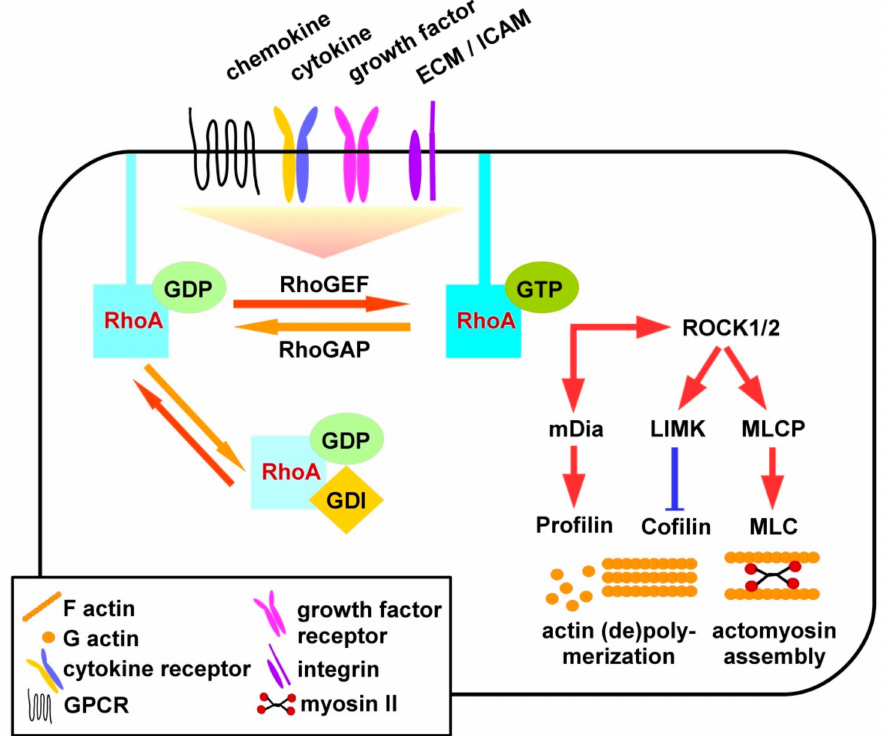
Figure 1. Scheme of RhoA signaling. Binding of exogenous ligands via di ff erent types of receptors as well as intracellular events trigger activation of RhoA GEF which, in turn, engage membrane-bound RhoA and mediate the exchange of GDP by GTP resulting in RhoA activation. GAP elevate the GTPase activity of RhoA, thereby promoting its inactivation. GDI translocate RhoA from the membrane and keep it in an inactive state. Active RhoA via protein kinases regulates cytoskeletal rearrangements. Active RhoA via ROCK / LIMK negatively regulates cofilin, which is required for F-actin turnover. Additionally, ROCK via inhibition of MLCP confers activation of MLC promoting actomyosin